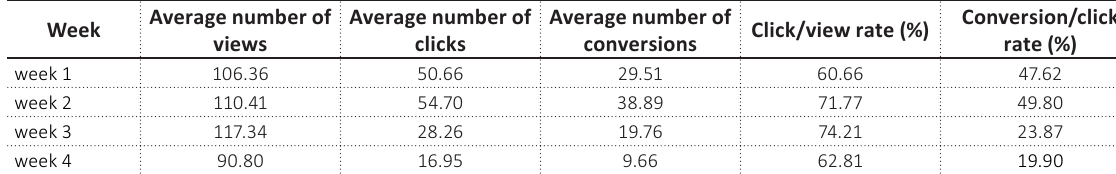
Table 4. Average retargeting performance per week